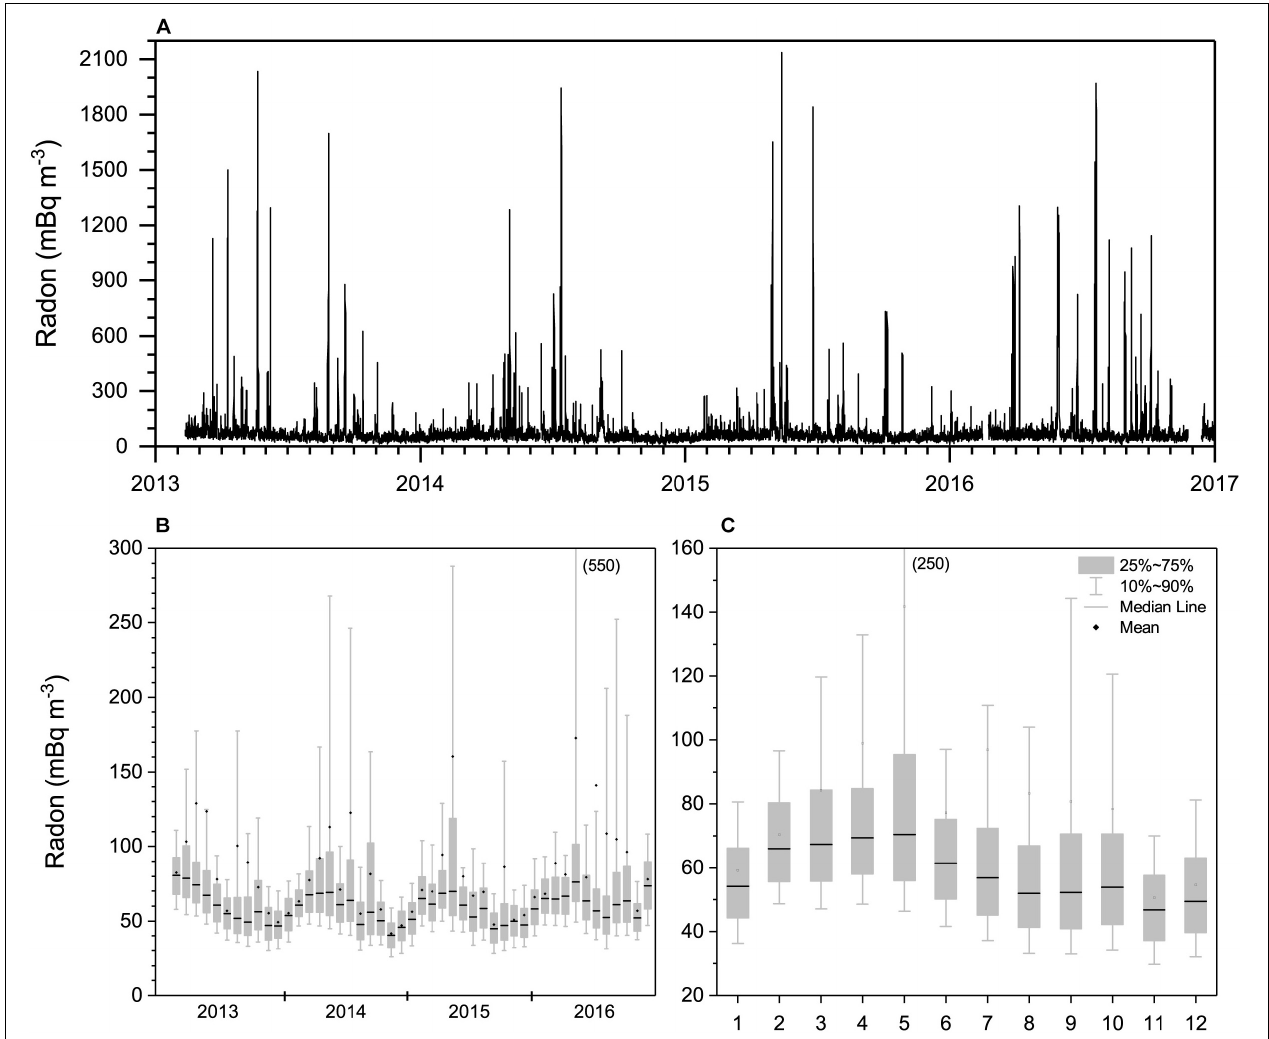
FIGURE 7 | (A) Hourly, and (B,C) monthly distributions of KSG radon concentrations between 2013 and 2016. Refer to key for distribution box-plot details.